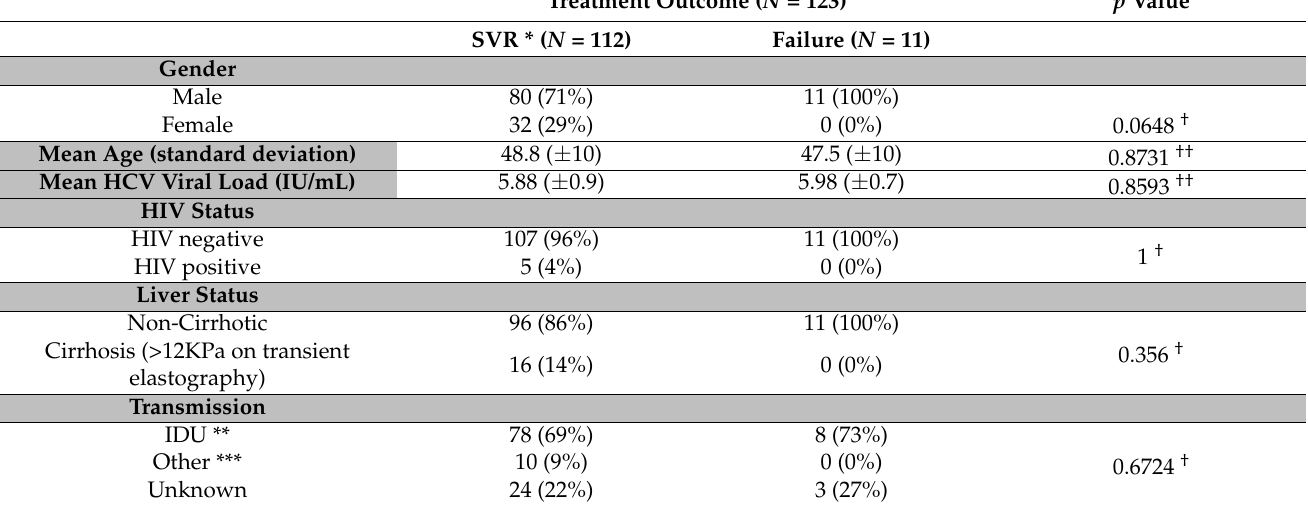
Table 1. Summary of demographic and clinical characteristics of HCV genotype 2 infected individuals treated with G/P between 2013 and 2019. * SVR = sustained virological response, ** IDU = injecting drug use. *** This includes other transmission risks including sexual transmission, tattoos and transmission through blood product administration. † Fisher’s exact test used. †† Wilcoxon rank sum test